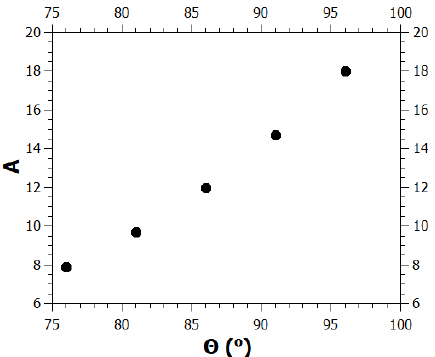
Figure B1. Pairs of contact angle and FHH parameter A values that produce good model fits to the adsorption data.